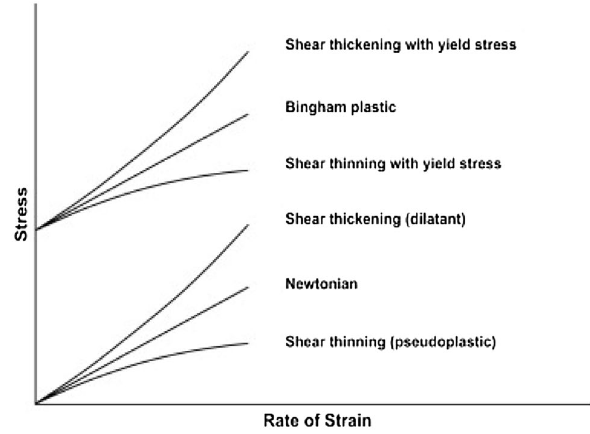
Fig. 2 The graph of stress versus strain in shear